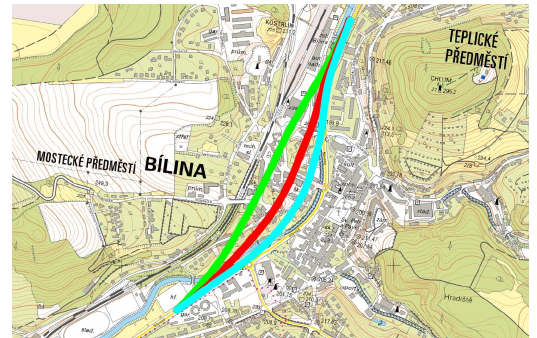
Figure 1. Site plan of the area of interest including Variant Z tunnel alignment